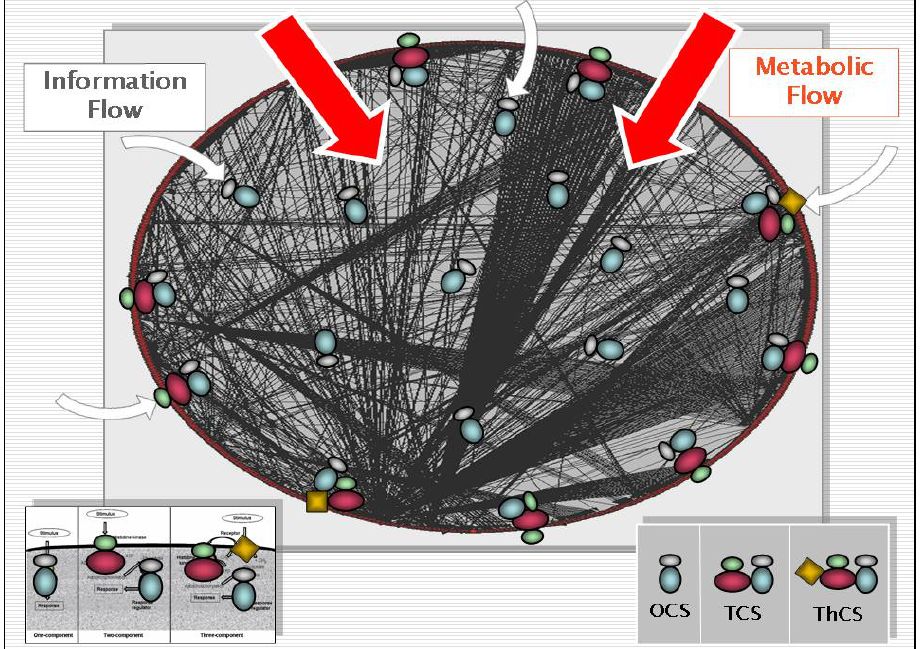
Figure 2. Metabolic flows and signaling or communication flows are shown respectively as thick (red) arrows and as thinner (white) ones. The representation highlights the difference in kind between faint communication flows, mediated by receptor binding, and bulk metabolic flows, which are actively introduced by permeases, transporters, and pumps. The figure also shows the three characteristic signaling pathways developed by prokaryotes: One Component Systems (OCS), Two Component Systems (TCS), and Three Component Systems (ThCS). These three different options imply very different information processing capabilities and metabolic costs (see Marijuán et al.